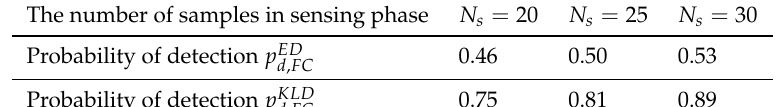
Table 2. Sensing performance at the FC for CR-IoT networks with a given false alarm probability = p KLD = 0.2). ( p ED f , FC f , FC